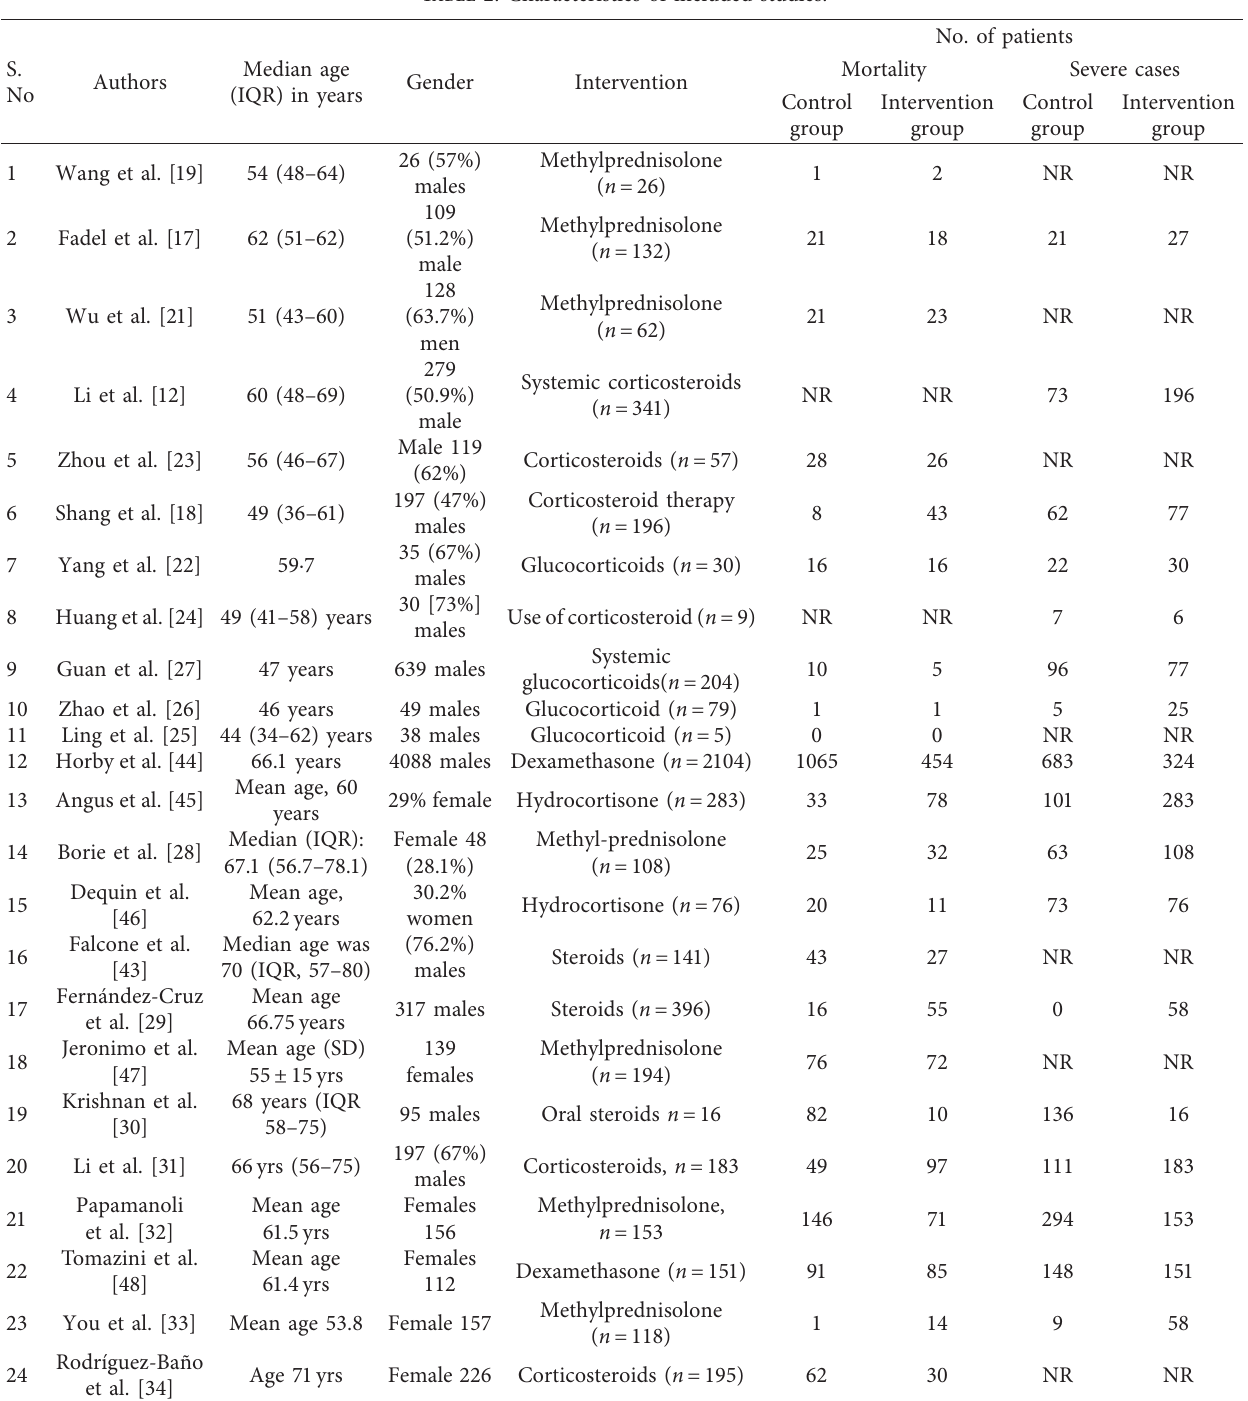
Table 2: Characteristics of included